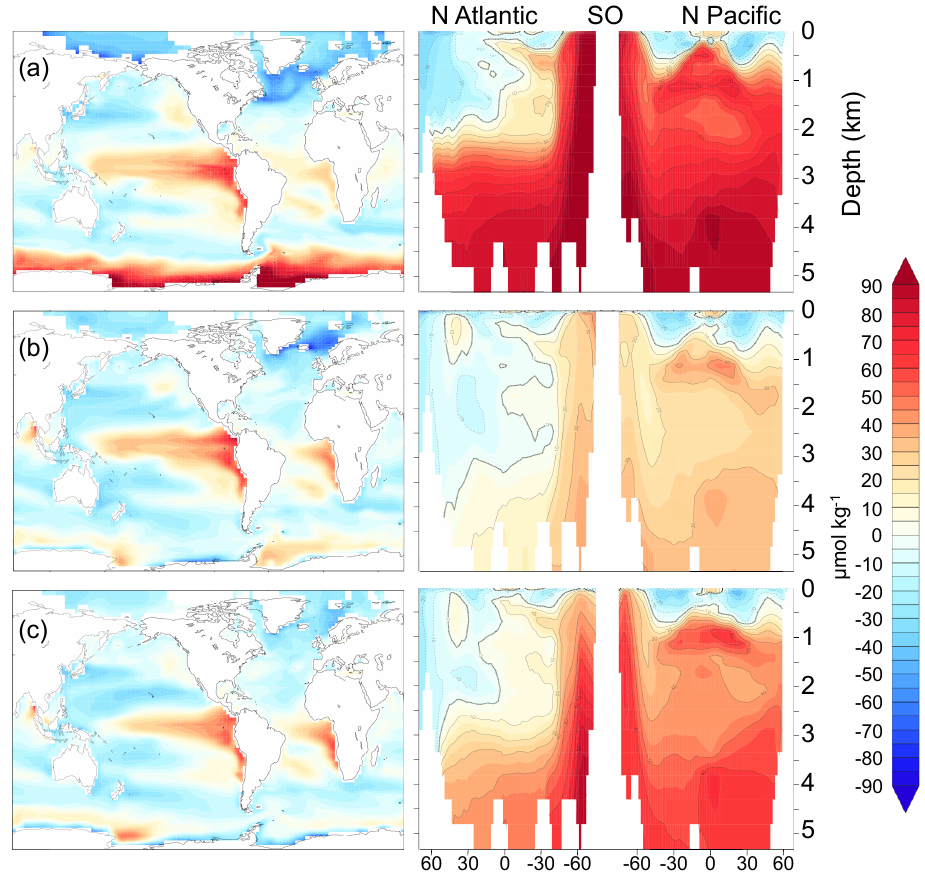
Figure 7. DIC dis (µmolkg − 1 ) for simulations (a) cold world; (b) moderate world; (c) hot world (see Sect. 2.2). Depth transects represent the North Atlantic (left), Southern Ocean (center), and North Pacific